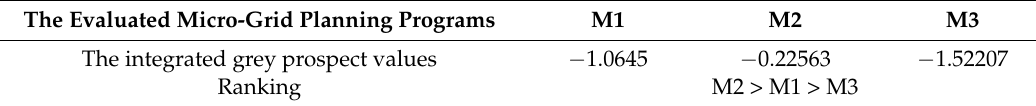
Table 11. The integrated grey prospect values and rankings of the evaluated micro-grid planning programs. The Evaluated Micro-Grid Planning Programs M1 M2 M3 The integrated grey prospect values − 1.0645 − 0.22563